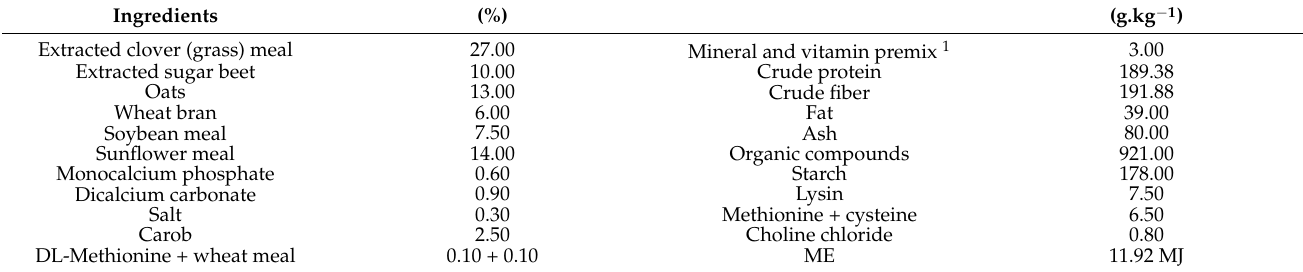
Table 1. Ingredients, chemical composition, and nutritive value of